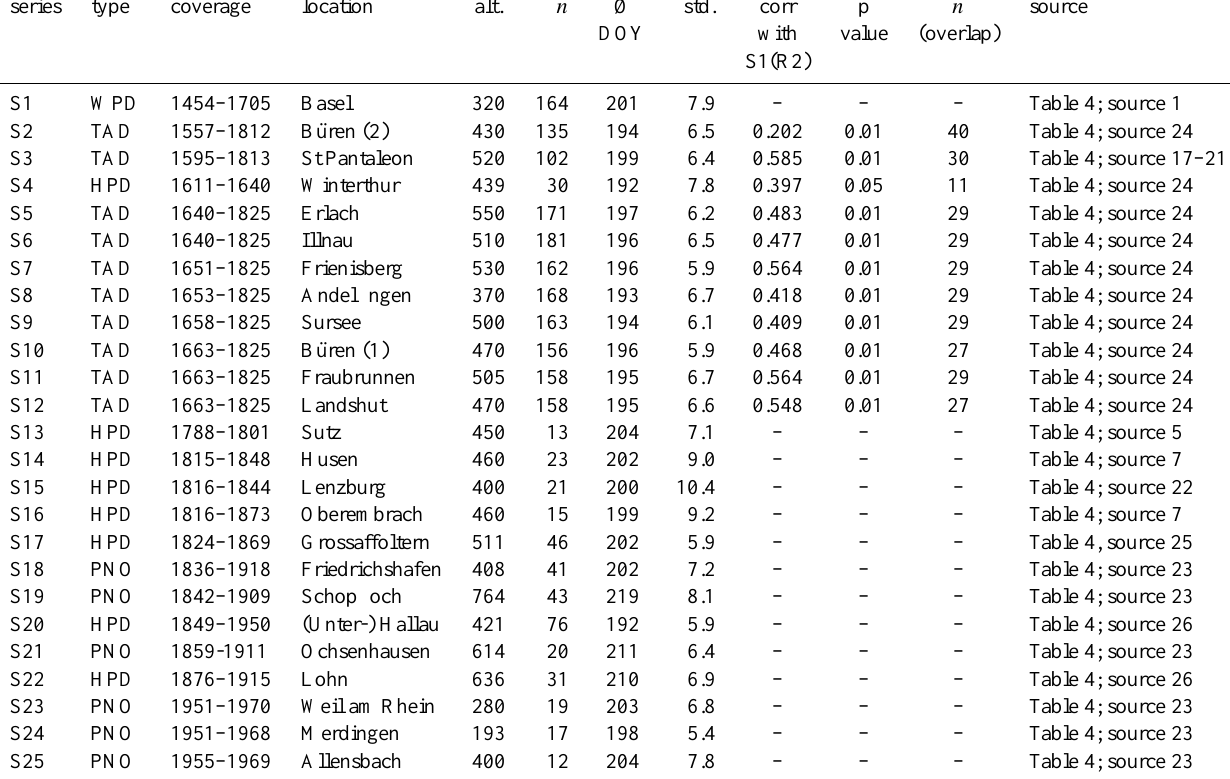
Table 2. Metadata of partial WGHD series (WPD, TAD, HPD and PNO series). WPD=Wage Payment Data; TAD=Tithe Auction Data; HPD=Historical Phenological Data; PNO=Phenological Network